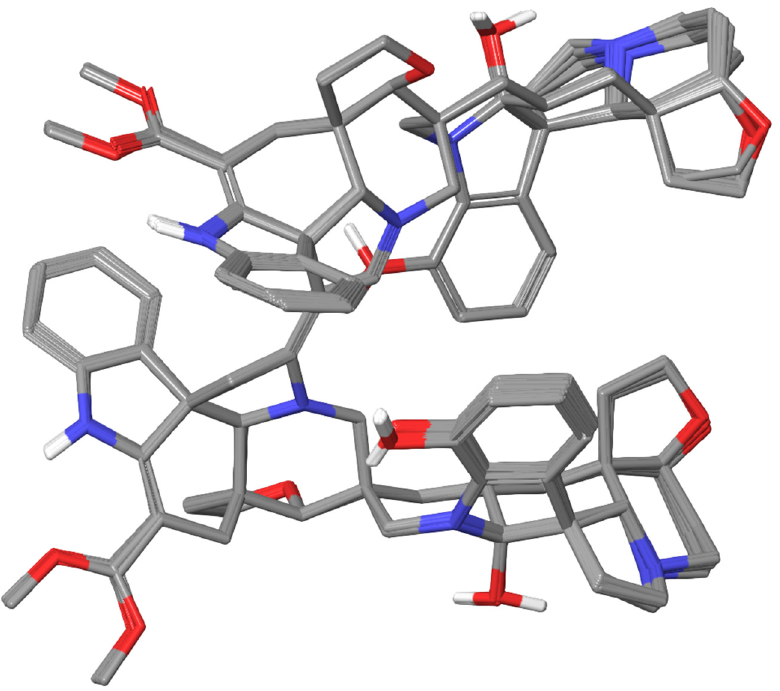
Figure 3. Superimposed structures of a set of the low-energy conformers of group b obtained by conformational search throw.